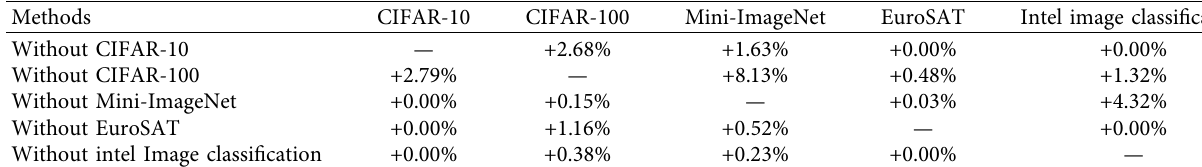
Table 4: Impact between domains based on CDCL.